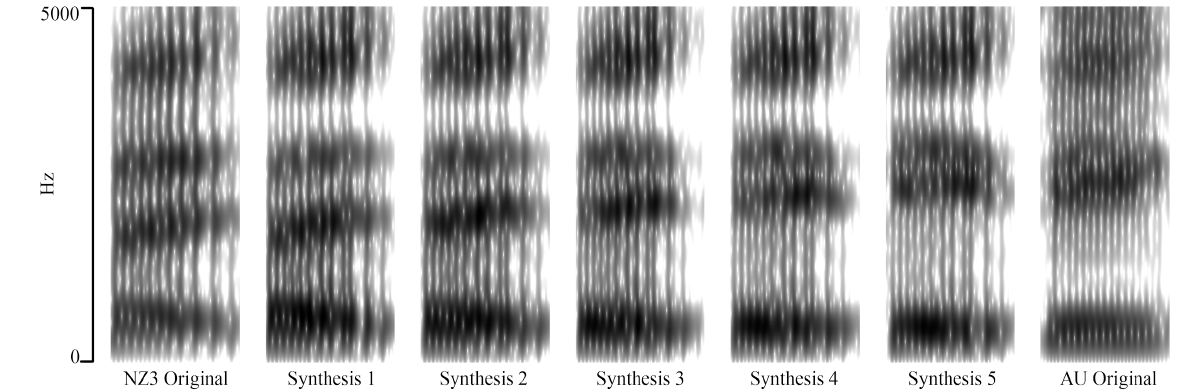
Figure 2. Five-step vowel continuum synthesis of the word ‘fixture’ proceeding from most New Zealand-like (NZ3 original recording) to most Australian-like (AU original recording). Table 3. Continua formant values (Hz) for the word ‘fixture’ at T-step 15 (median).